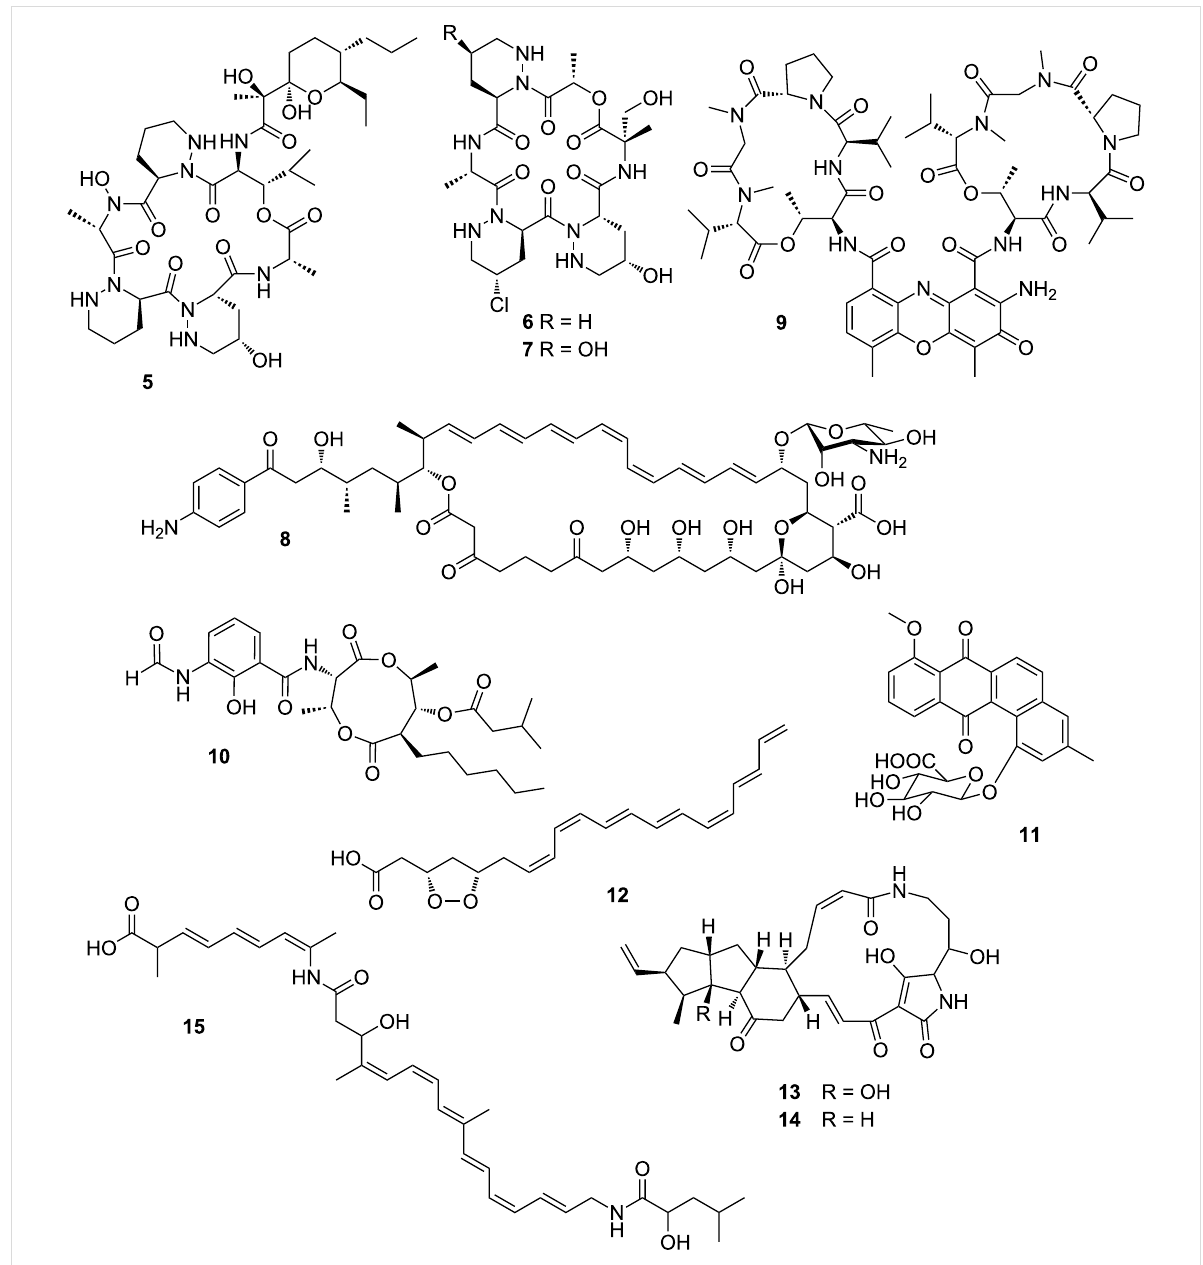
Figure 5: Small molecules (chemical mediators) play key roles in maintaining garden homeostasis in fungus-growing insects: dentigerumycin ( 5 ), gerumycin A ( 6 ), gerumycin C ( 7 ), candicidin D ( 8 ), actinomycin D ( 9 ), antimycin A1 ( 10 ), pseudonocardone B ( 11 ), mycangimycin ( 12 ), frontalamide A ( 13 ), frontalamide B ( 14 ), and bacillaene A ( 15 ).